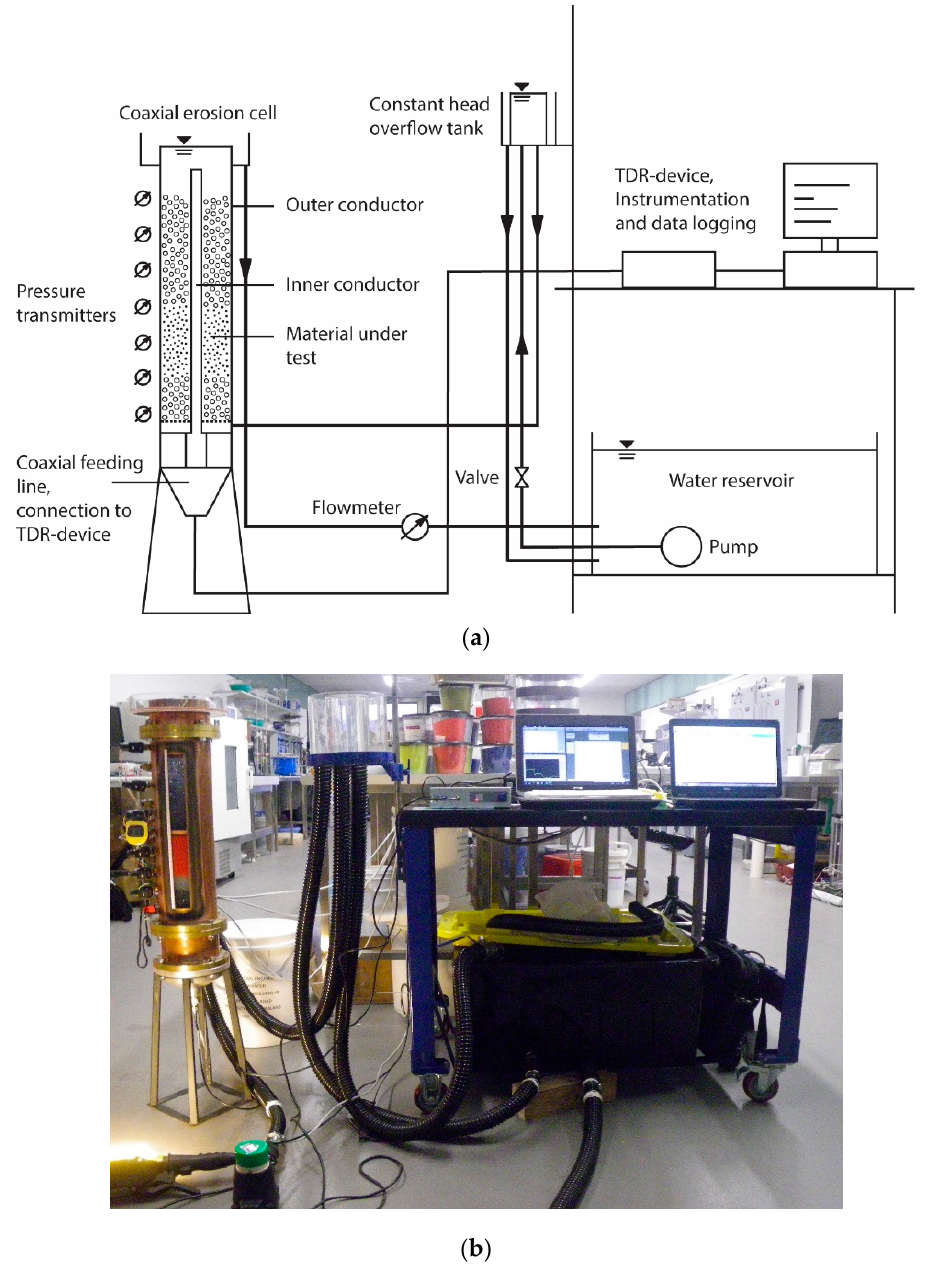
Figure 1. ( a ) Scheme of the experimental setup with the coaxial erosion cell (not to scale); ( b ) photograph of the setup.